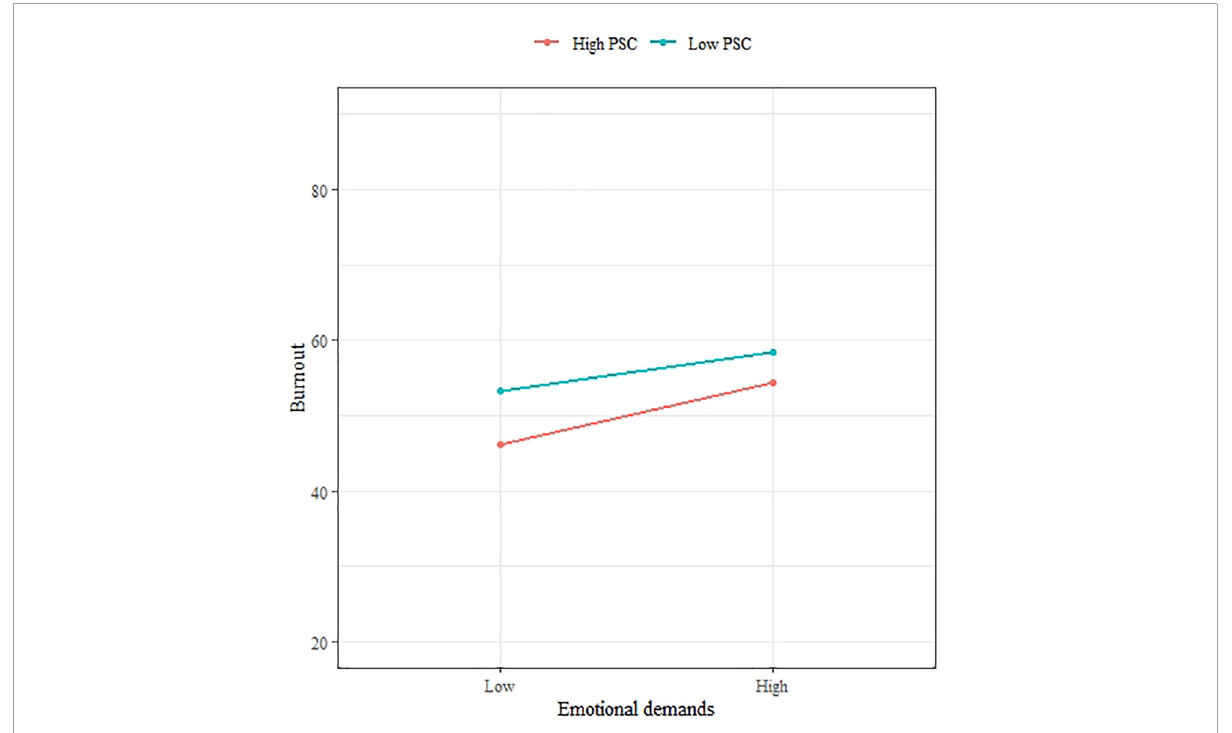
studies conducted in different occupational settings where PSC- 4 was adopted (Dollard, 2019; Berthelsen et al., 2020); higher levels of PSC were also found in other studies with PSC-12